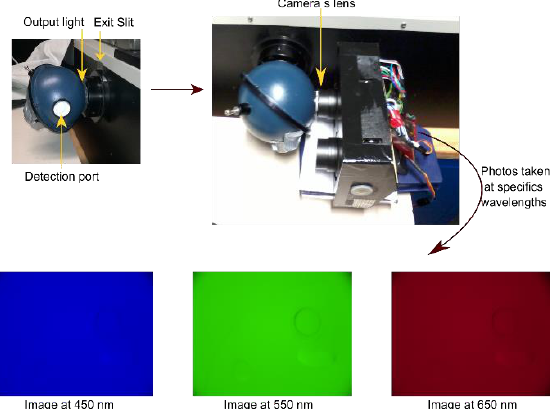
Figure 1: The monochromator and camera setup and three example images of the inside of the integrating sphere at different wavelengths.